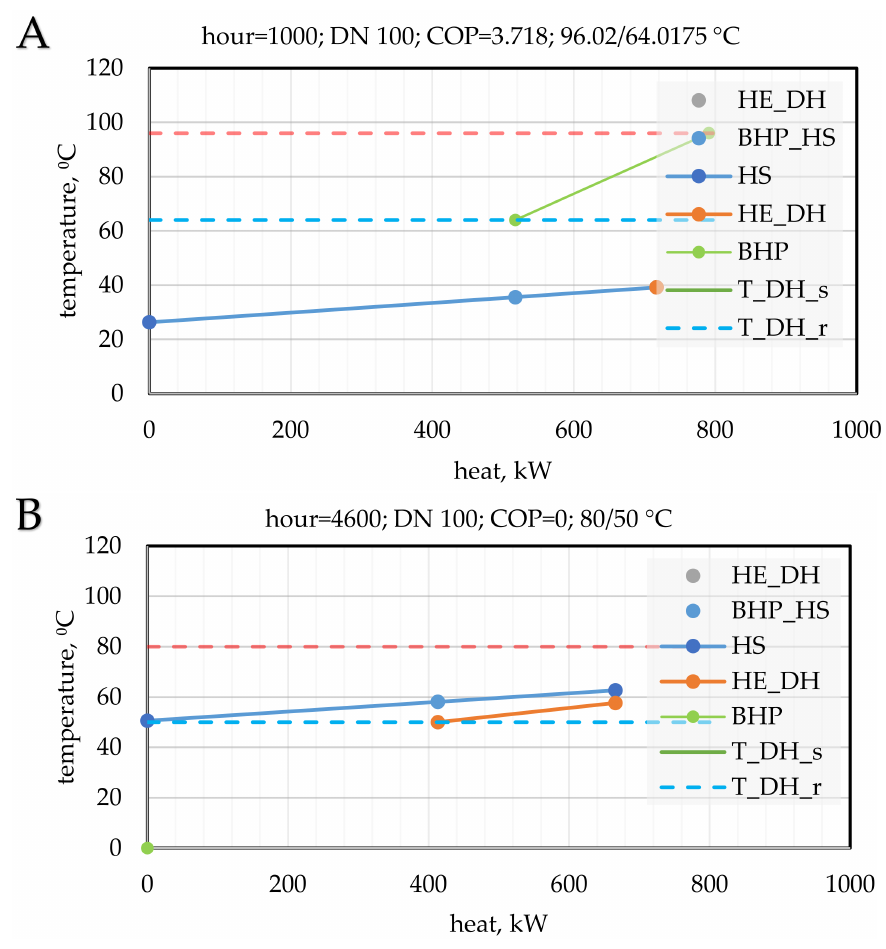
Figure 16. Pinch analysis results—Scenario A. ( A ) BHP utilization; ( B ) HE